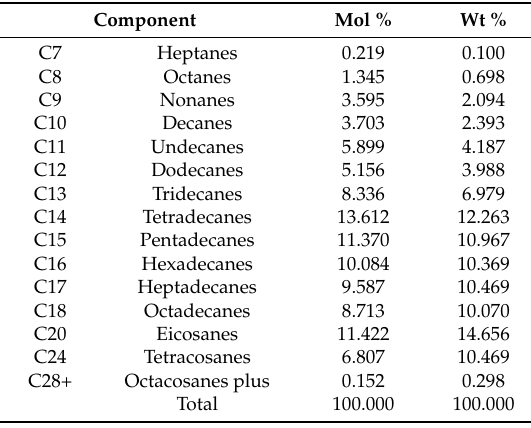
Table 4. Composition of the Diesel Oil Used in This